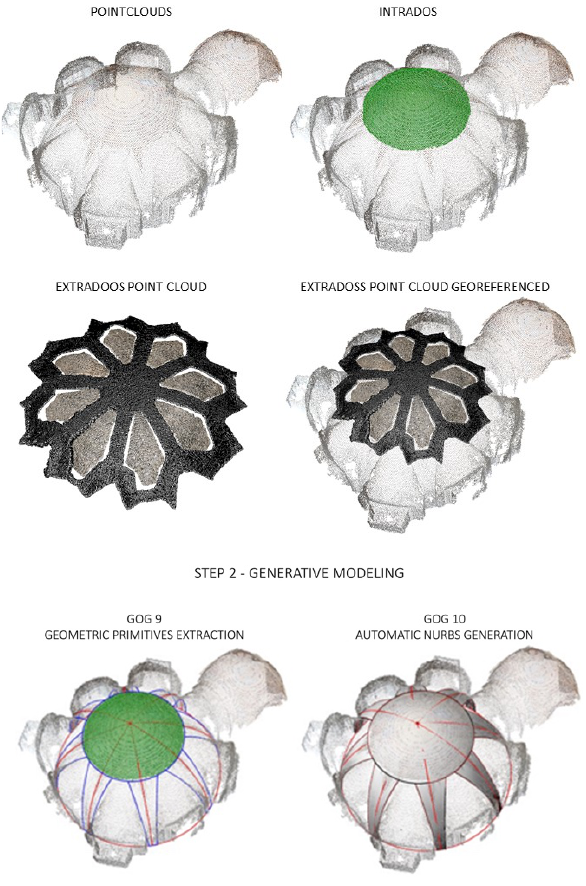
Figure 5. Step 1 – Post processing: Point clouds layers